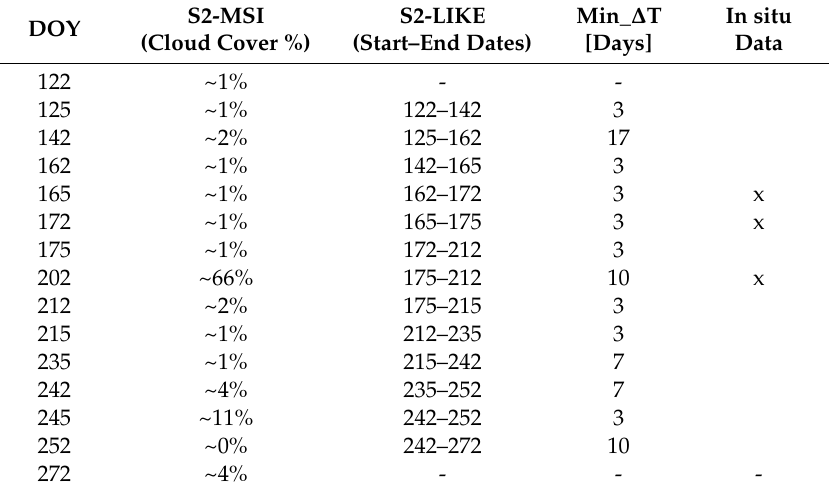
Table 2. Day-of-year (DOY) of available S2-MSI images (% of cloud cover), synthetized S2-LIKE images (the corresponding subperiod start–end dates) and in situ measurements, as well as the temporal interval ( Min _ ∆ T) between DOY of S2-LIKE images and the closest start or end date of the corresponding subperiod